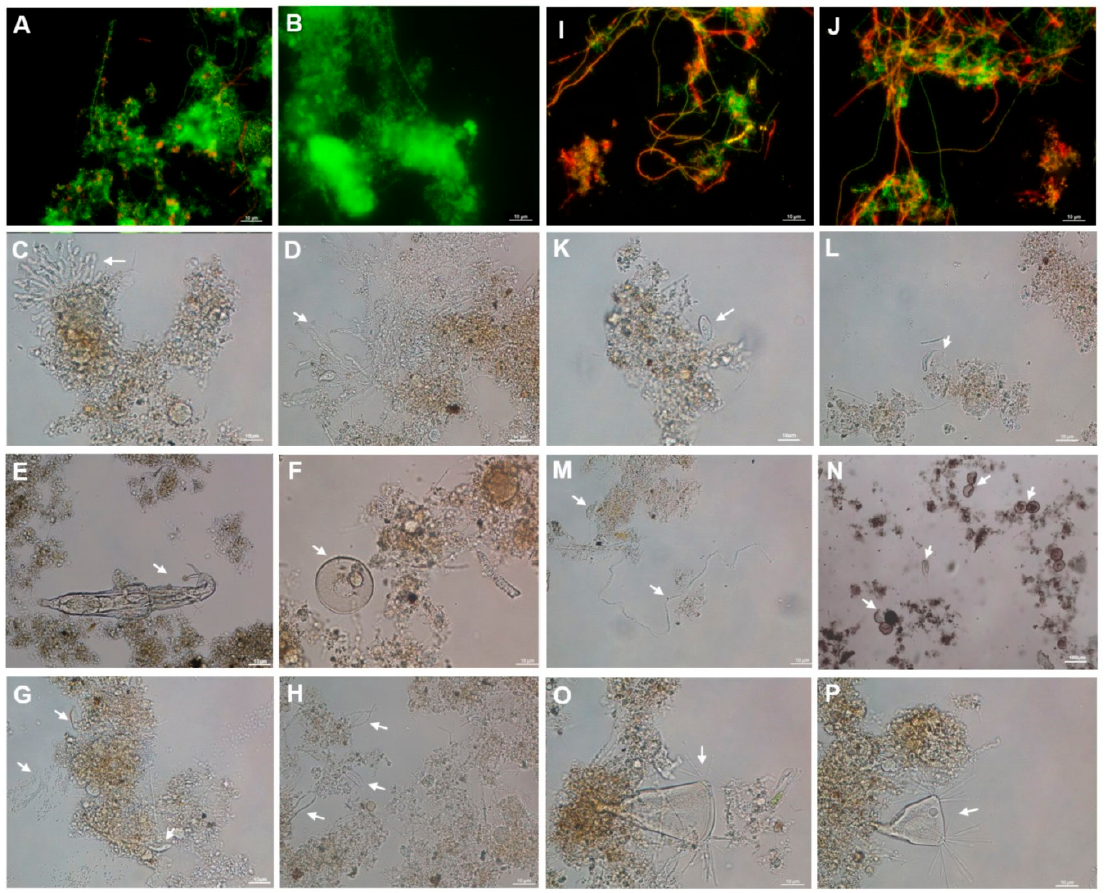
Figure 9. Structure of the AS flocs from the SBR C ( A , B ) and SBR KPL ( H , I ) after 64 days of wastewater treatment. The occurrences of selected microorganisms are marked with white arrows that indicated Zooglea fingered in gelatinous matrix ( C , D ), rotifers ( E ), Arcella ( F ), free bacteria ( G ), ciliate, and filamentous bacteria ( G , H ) in the SBR C , as well as ciliate ( K , L , M ), filamentous bacteria ( M ), empty Arcella shells ( N ), Vorticella ( N ), and suctorians ( O , P ) in the SBR KPL .